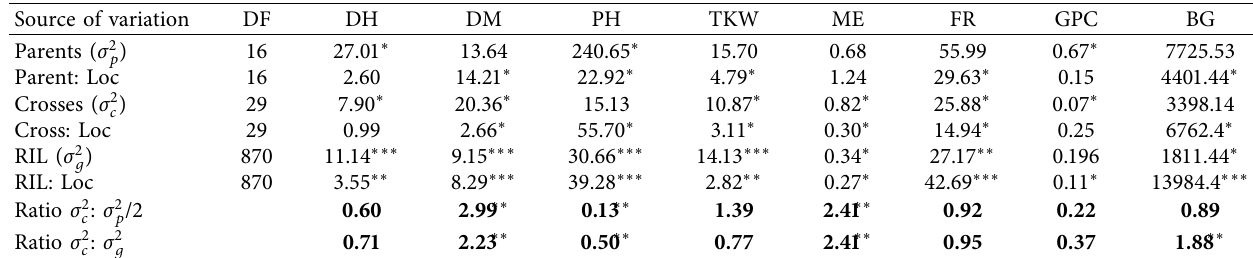
Table 6: Variance components for the genetic and genotype × location effects of parents, crosses, and RIL within crosses estimated from the combined analysis over